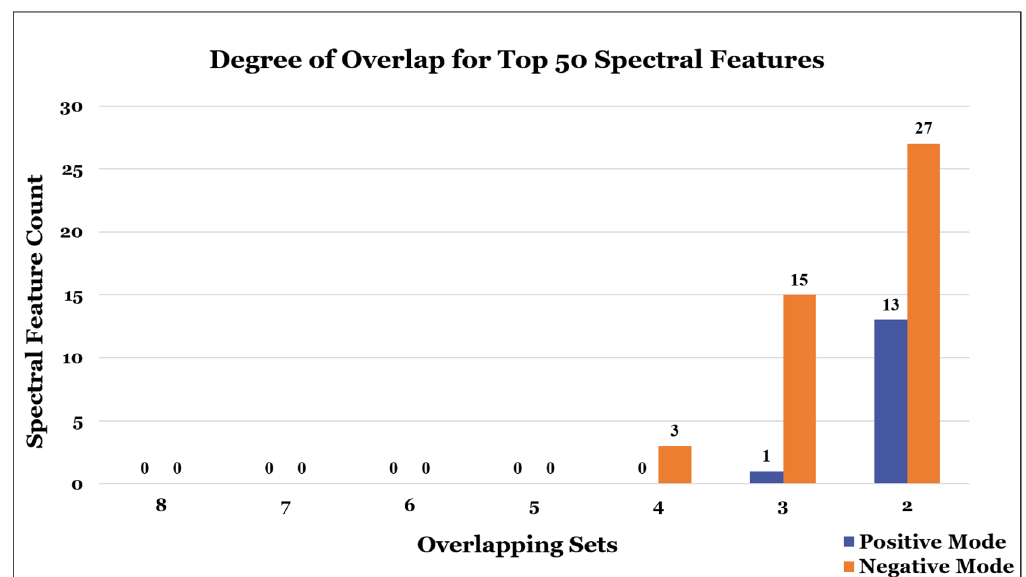
Figure 4. Overlap of the top 50 spectral features. The total number of overlapping features found between the lists of the top 50 most perturbed spectral features from each of the 8 participants, as a function of the number of groups they were found in. There were no features found to be shared by all 8 lists. When 4 lists were considered, 3 negative mode features were found to be shared. Overall there was far more overlap in the negative mode lists, with a total of 15 features shared by any combination of 3 lists, and 27 features by any combination of 2 lists. Only 1 feature was found to be shared by any 3 lists in the positive mode, and 13 features found to be shared by any combination of 2 lists.